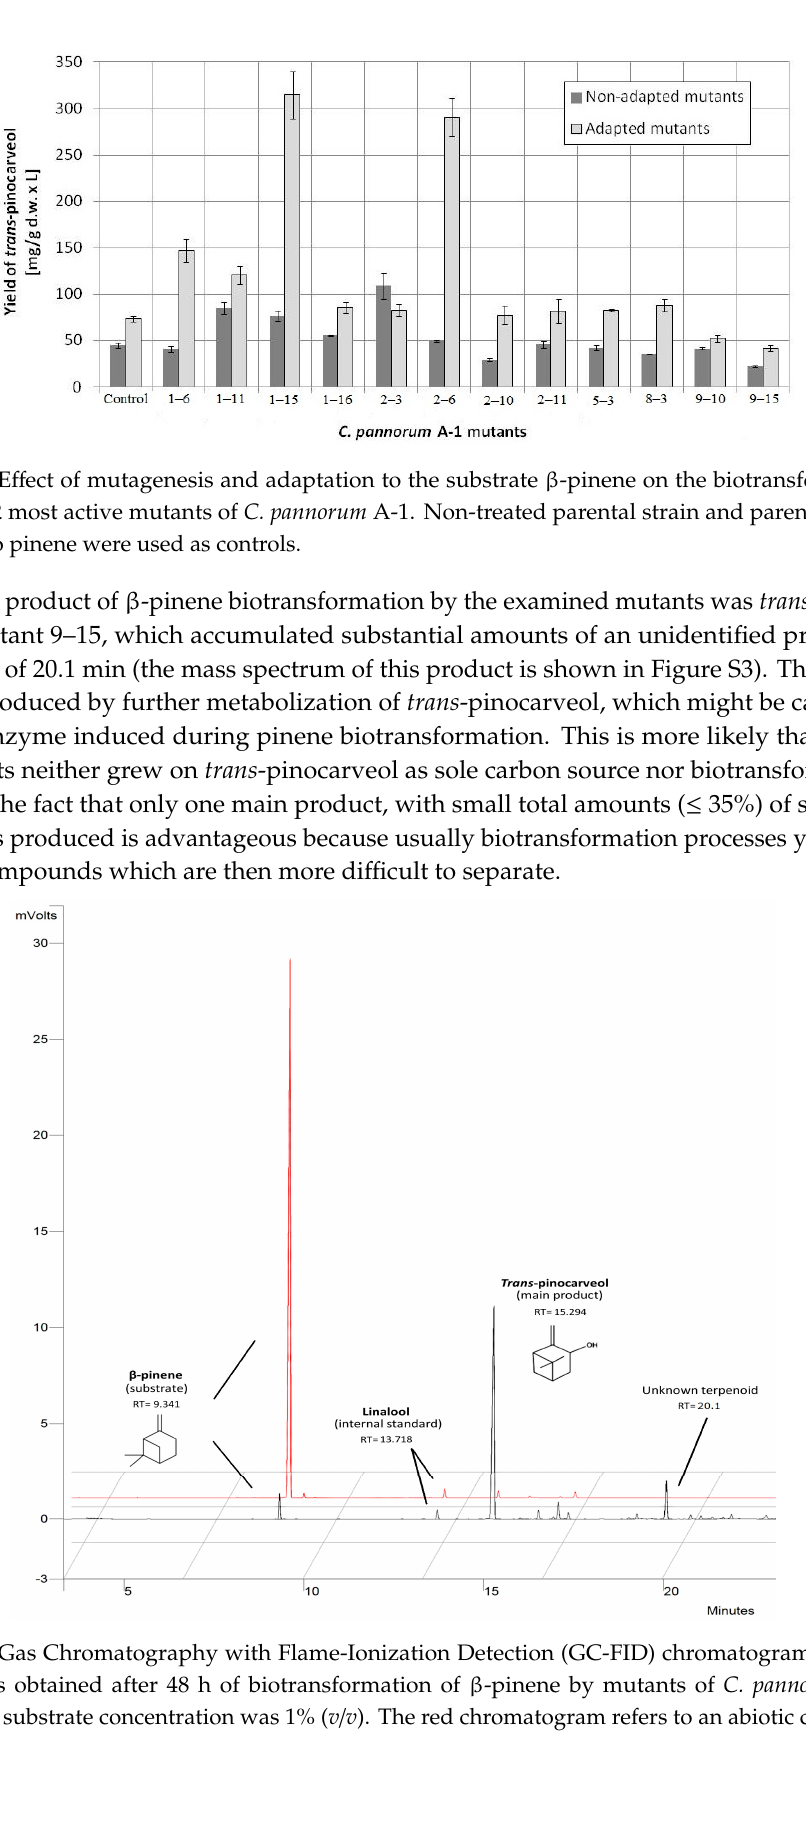
Figure 1. General metabolic activity (GMA) of 12 mutants of C. pannorum A-1 adapted to toxic β -pinene and selected for their high biotransformation ability. A non-treated wild strain was used as a control. Biomass concentration in each sample was 5 g dry mass per L.